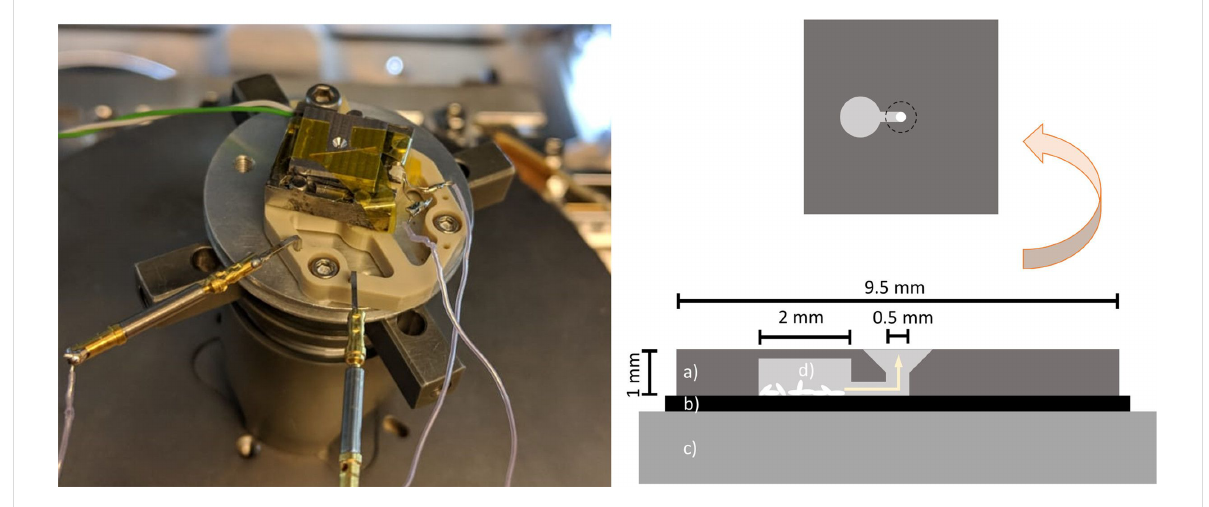
Figure 2: Substrate heater and precursor supply system of the deposition setup. Only the conical hole in the centre, through which the deposition is done, is visible. The precursor crystals are stored underneath the top metal cover. (a) Vapour guide, (b) silicon substrate, (c) substrate heater, and (d) precursor crystals. The sketch on top shows the bottom view of the vapour guide.